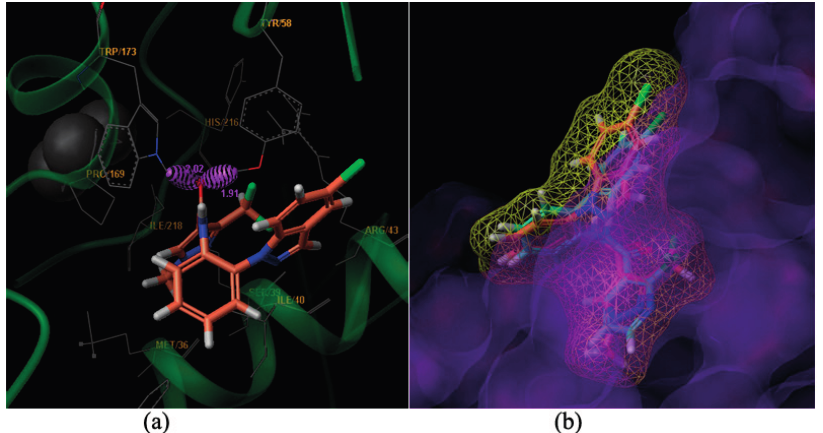
Figure 3. Surflex-Docking of compound 9m to complex II. ( a ) Interaction of 9m and amino acid residues near the ligands (3D diagram); ( b ) Connolly surface of complex II with compound 9m and boscalid shown as a stick